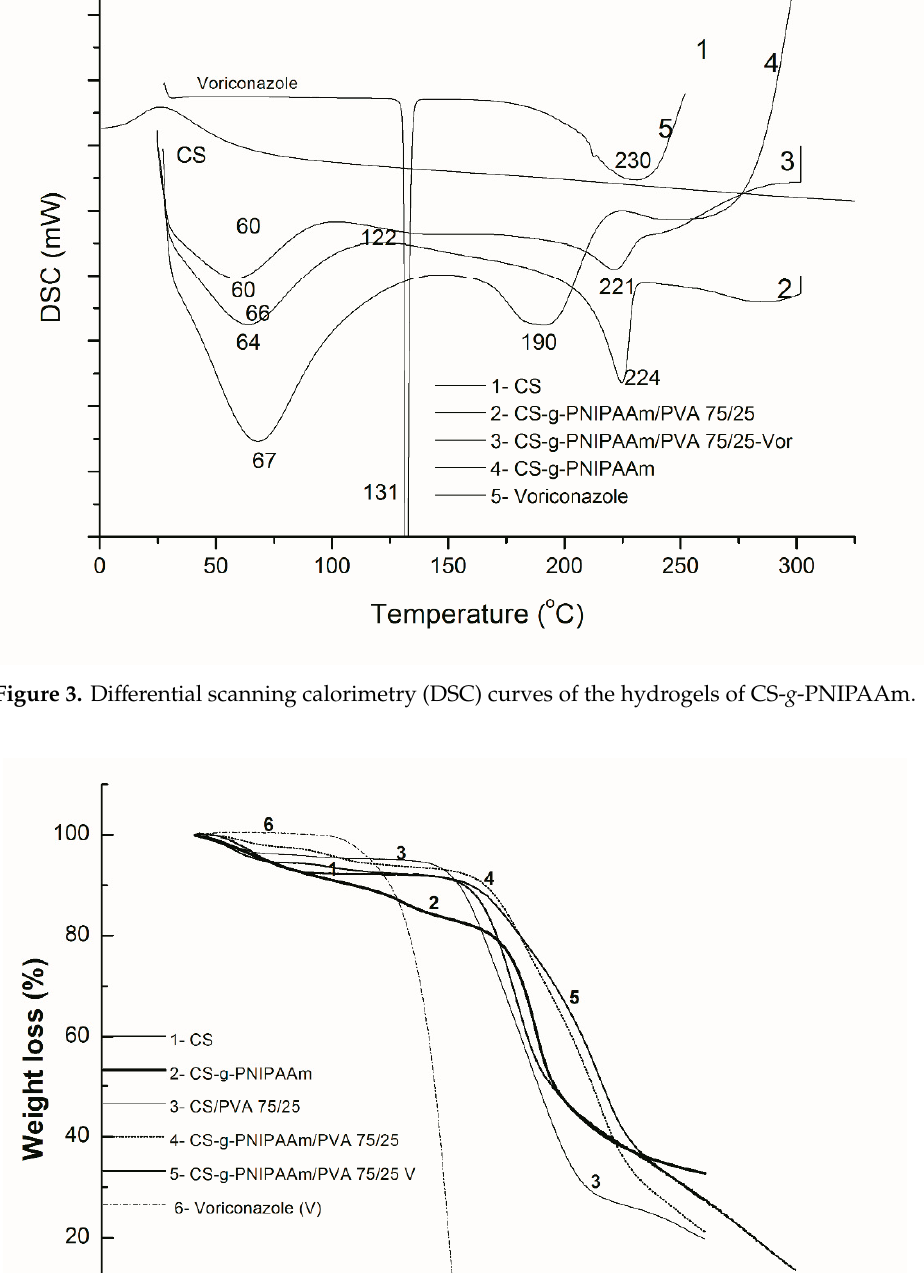
Figure 4. TGA/DTG curves of cryogels based on graft copolymer and pure constituents. ( a ) TG curves and ( b ) first derivative DTG curves.